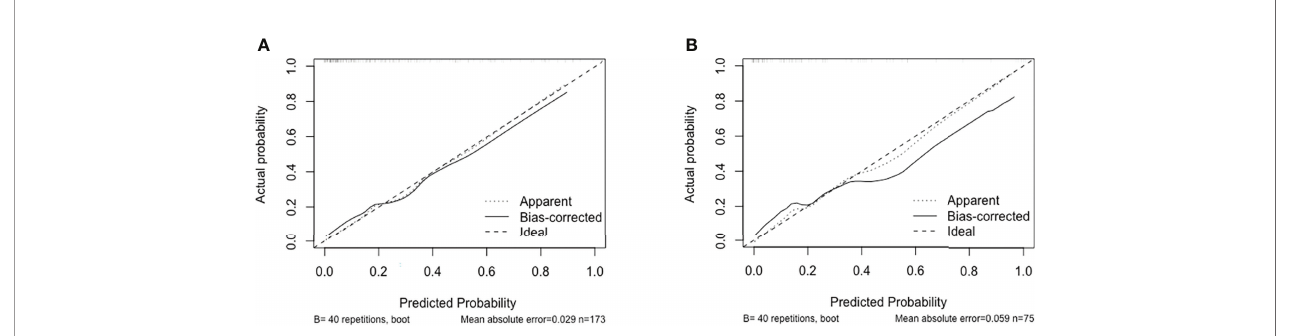
FIGURE 3 | Calibration curve of discrimination nomogram in (A) training group or (B) test group. The x-axis represents the predicted probability of MMN. The y-axis represents the actual diagnosed MMN. The diagonal dotted line represents a perfect prediction by an ideal model. The solid line represents the performance of the nomogram, of which a closer fi t to the diagonal dotted line represents a better prediction.